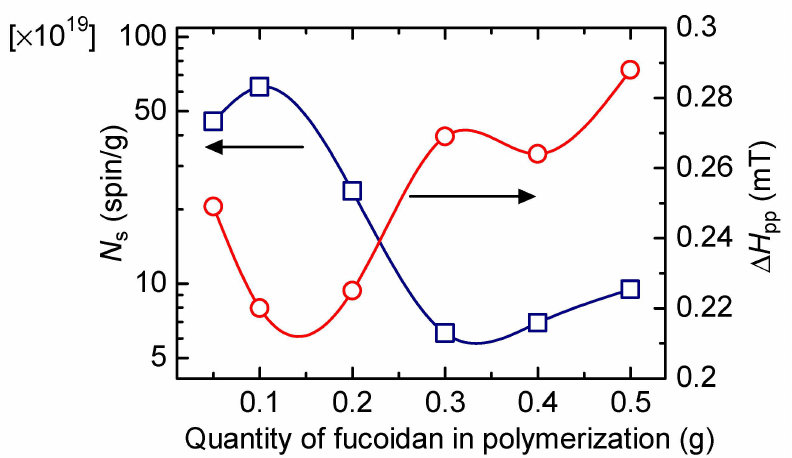
Figure 13. Electron spin resonance (ESR) results for PANI prepared with fucoidan (non-gel method, N05-5). Change in the spin concentration ( N s ) (blue line) and the ESR peak-to-peak line width ( ∆ H pp ) (red line) vs. quantity of fucoidan in